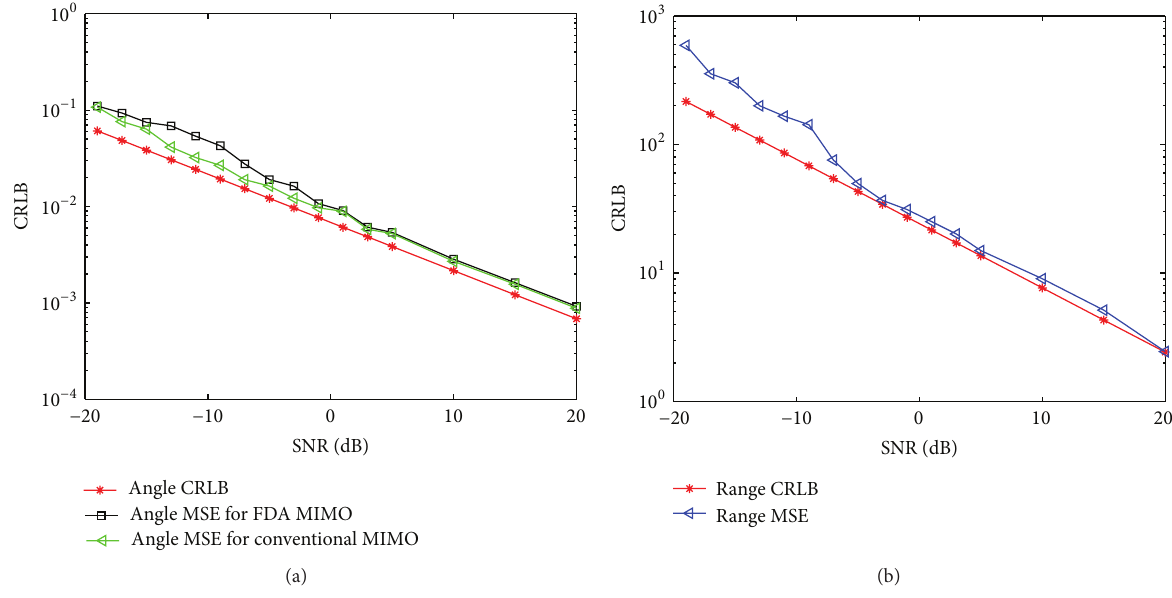
Figure 7: Comparison of CRLB and MSE for FDA MIMO radar: (a) angle estimation and (b) range estimation.